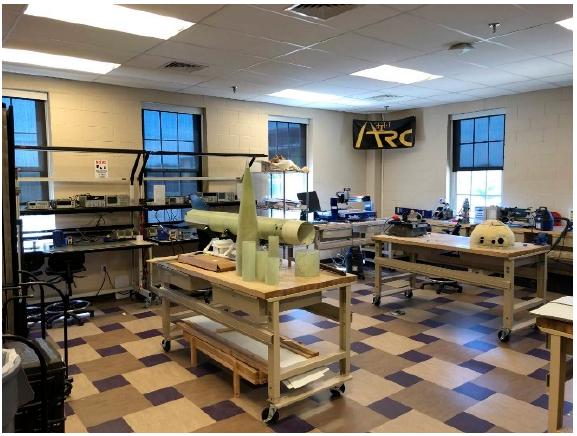
Figure 2. Fabrication and student club area of iMakerSpace .